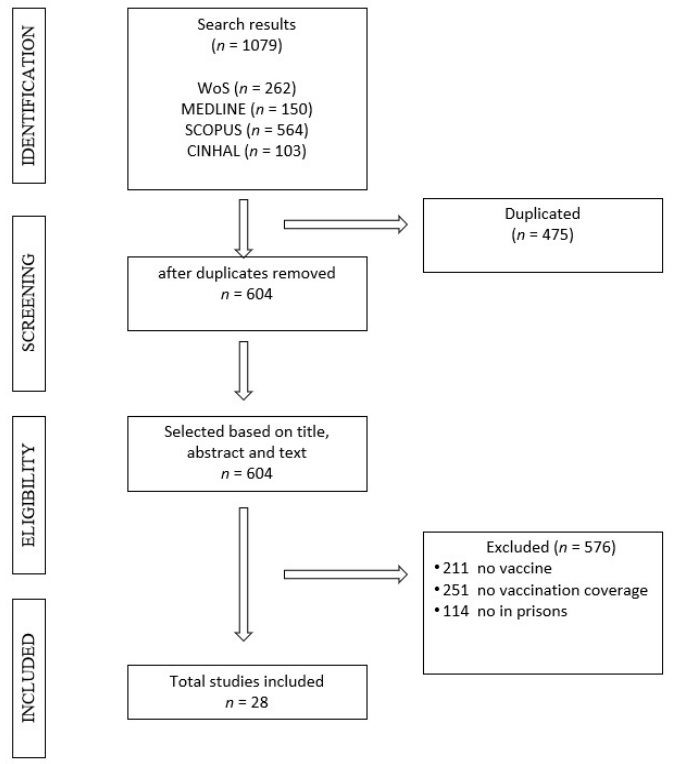
Figure 1. Flowchart selection process (PRISMA).